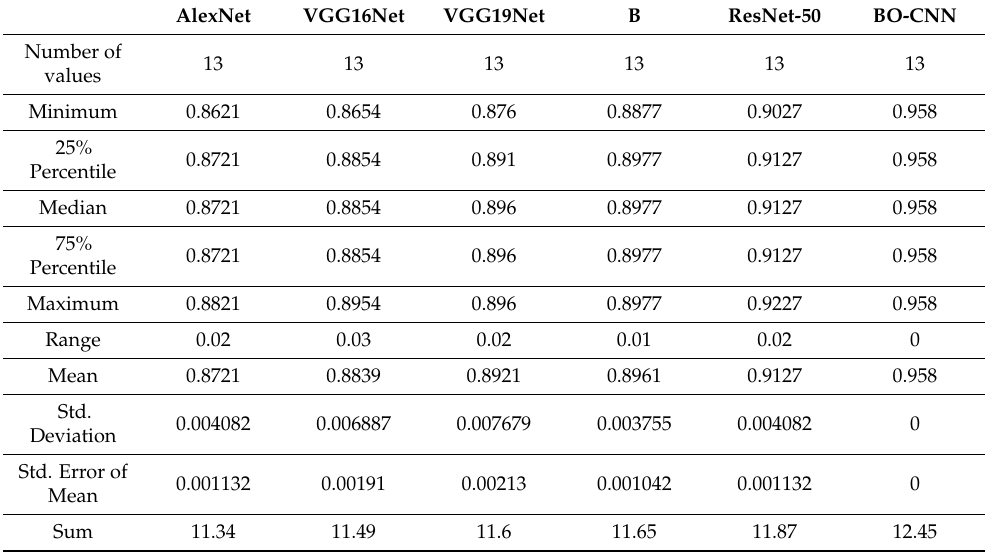
Table 9. Statistical description of the proposed BO-CNN model vs. pre-trained-CNN models for the OCT